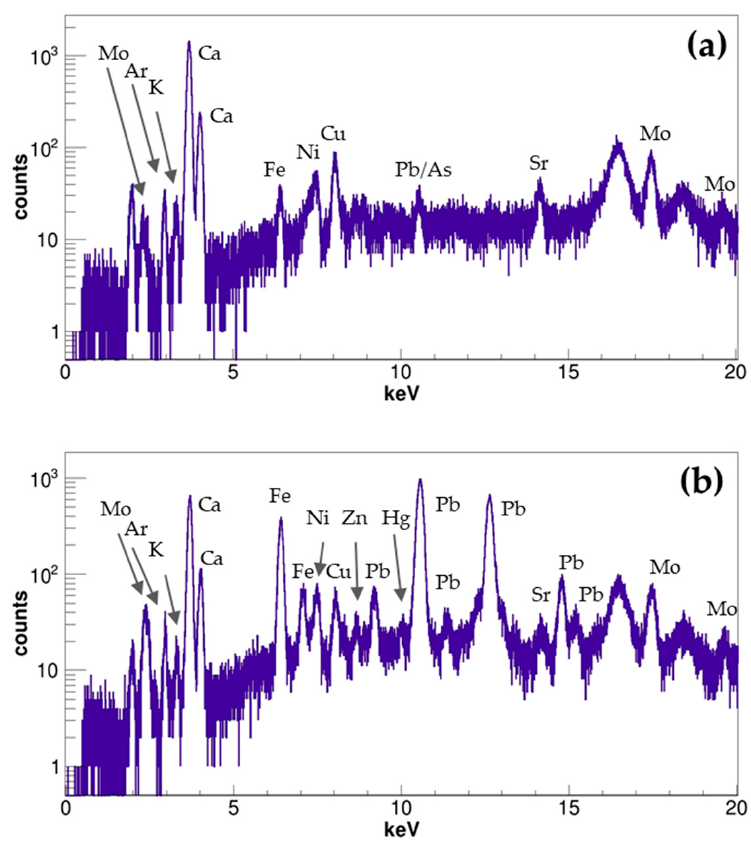
Figure 7. Spectra of the two points analysed with XRF: ( a ) red tone; ( b ) black tone. The presence of Ca probably due to ivory was detected in both.